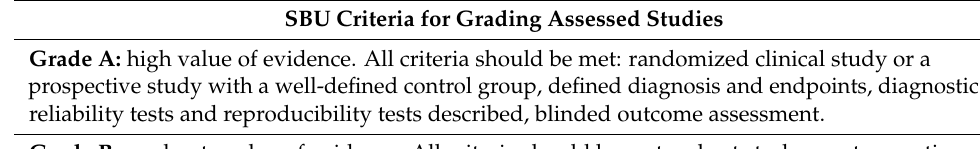
Table 2. The Swedish Council on Technology Assessment in Health Care Criteria for Grading Assessed Studies (SBU) criteria for grading assessed studies. SBU Criteria for Grading Assessed